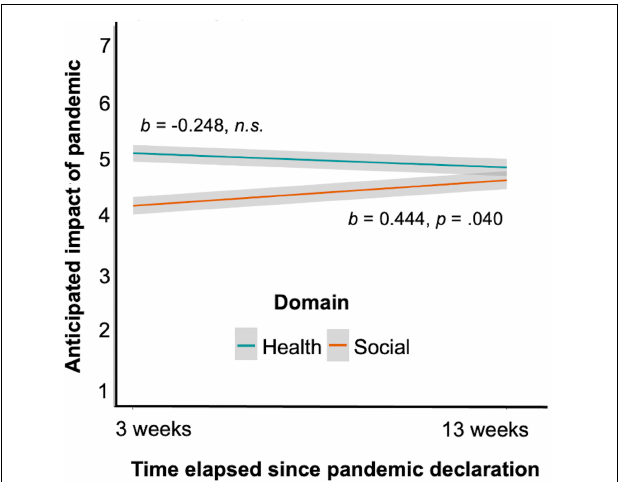
FIGURE 1 | Ratings of perceived impact for each domain (health, social) on a scale of 1–7, by survey date. 3 weeks after the declaration of a global pandemic, participants rated the likely health impact of the pandemic as significantly more severe than the likely social impact. 13 weeks after the pandemic declaration, participants rated the likely health and social impacts as indistinguishably severe. Perceptions of the likely social (but not health) impact of the pandemic increased significantly across the two timepoints. Error bars represent standard error of the mean.